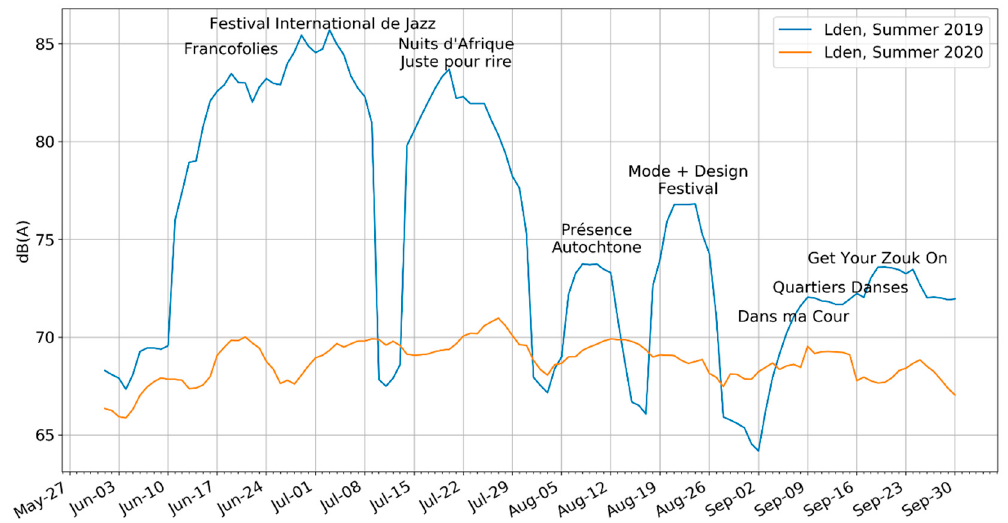
Figure 9. Sound levels comparing the summer of 2019 with 2020, using a weekly rolling average L den . The summer of 2019 is dominated by festivals, especially considering that the festivals often take place in the evening, when the L den applies a 5 dBA penalty on sound levels. In the absence of these festivals, the sound levels cannot be characterized as low.